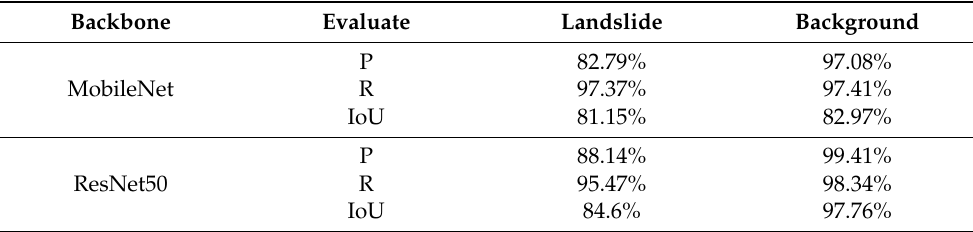
Table 6. The performance of PSPNet under different backbone networks. The numbers in bold are the highest IoU values obtained for landslide and background recognition,